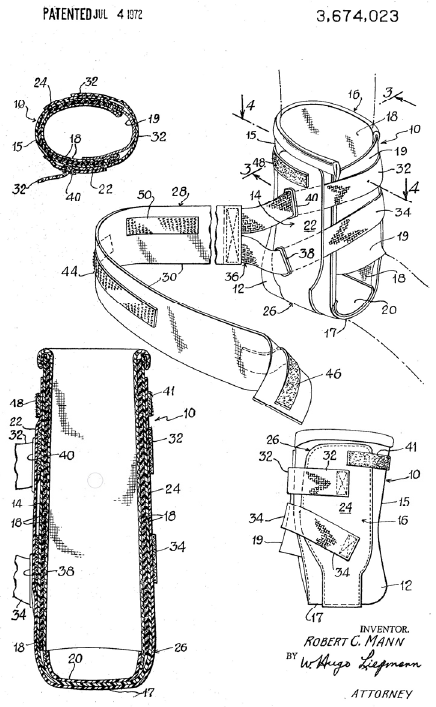
Figure 10. Earliest Patent on Brace: Ankle support providing high bracing strength